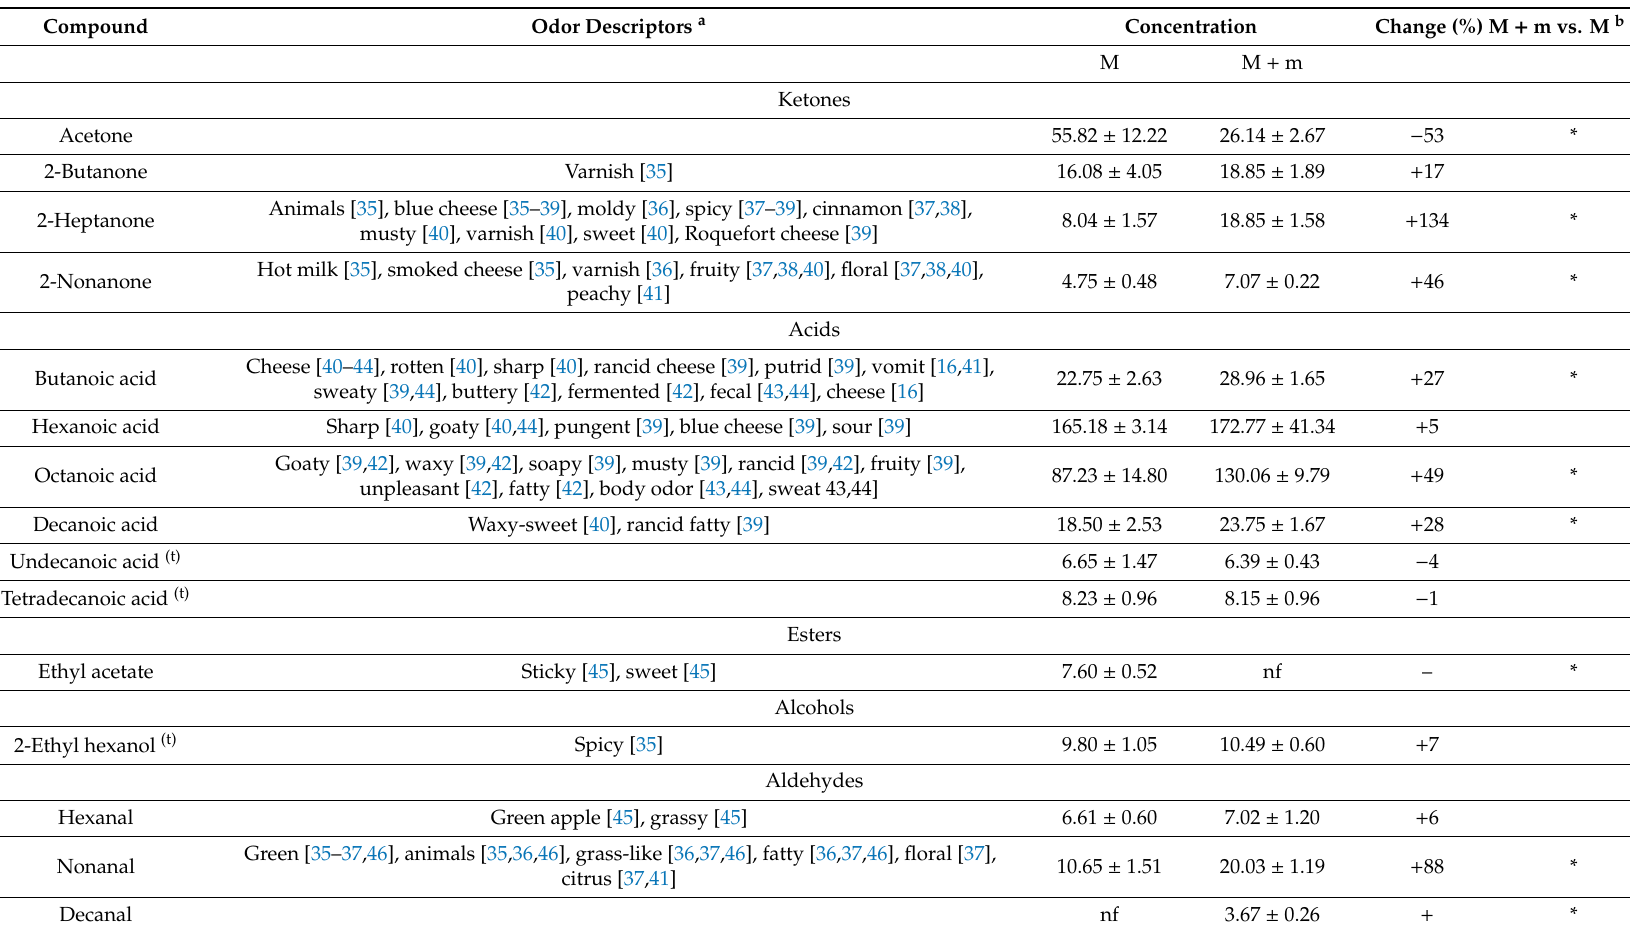
Table 3. Headspace concentrations ( µ g kg − 1 ) and odor descriptors of volatile compounds determined in milk samples obtained from bu ff aloes fed nonmycorrhizal (M) and mycorrhizal (M + m) maize